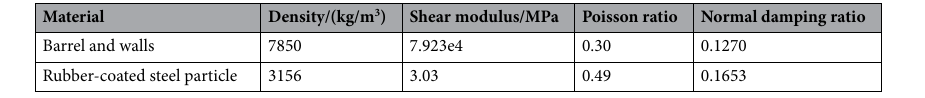
Table 1. Material physical parameters of damper.